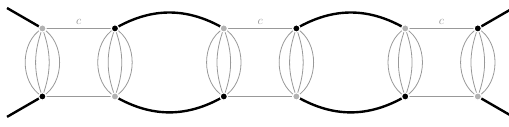
Figure 7: The length-two melonic four-point